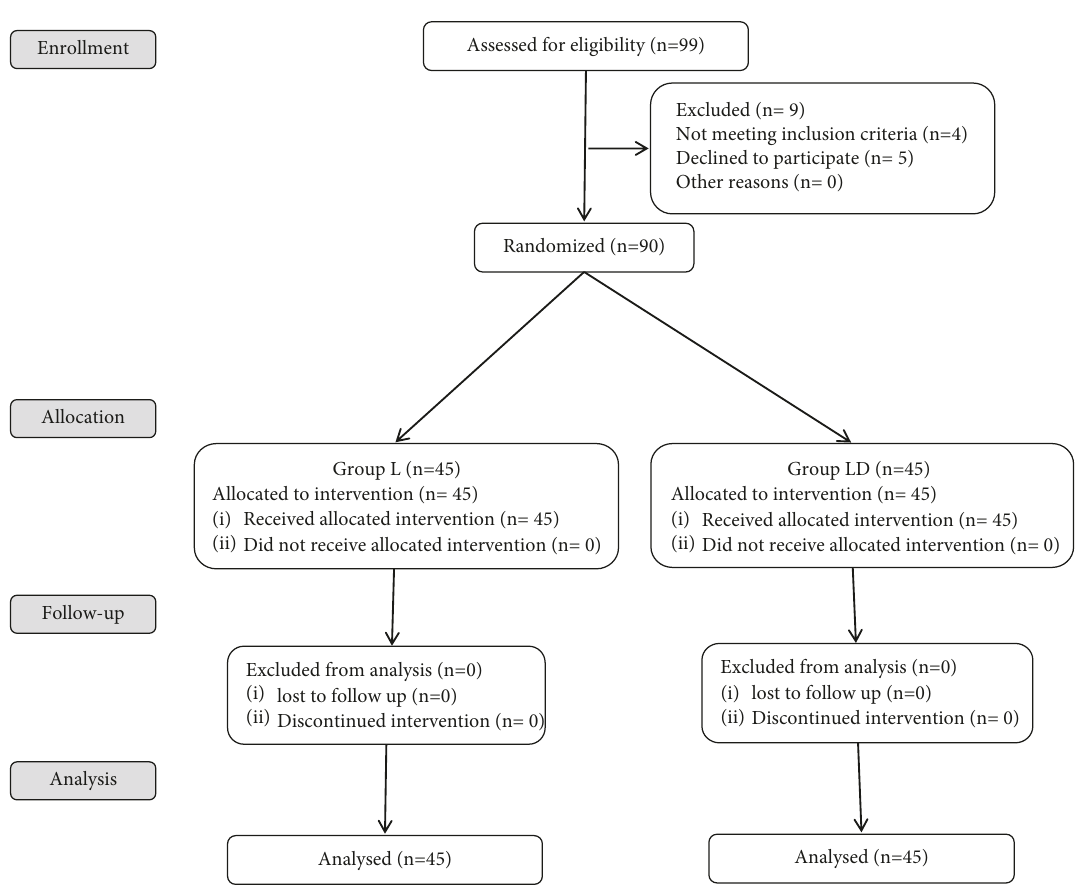
Figure 1: The consort flow chart.